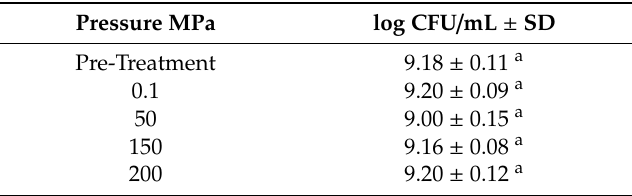
Table 2. Viable colony-forming units ± Standard Deviation (SD) of Lb. paracasei A13 before and after HPH treatment at 0.1, 50, 150 and 200 MPa. Means followed by di ff erent letters are significantly di ff erent p <